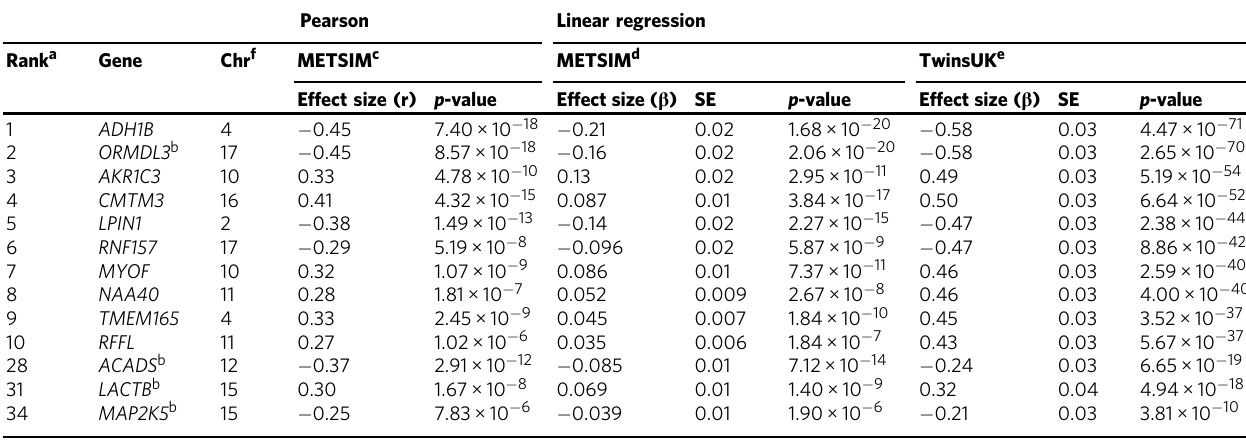
Table 1 Thirteen representative eGenes (9 most signi fi cant genes and 4 GWAS loci) that correlate with BMI in METSIM and TwinsUK (for the full data on all 54 genes, see Supplementary Table 6) Pearson Linear